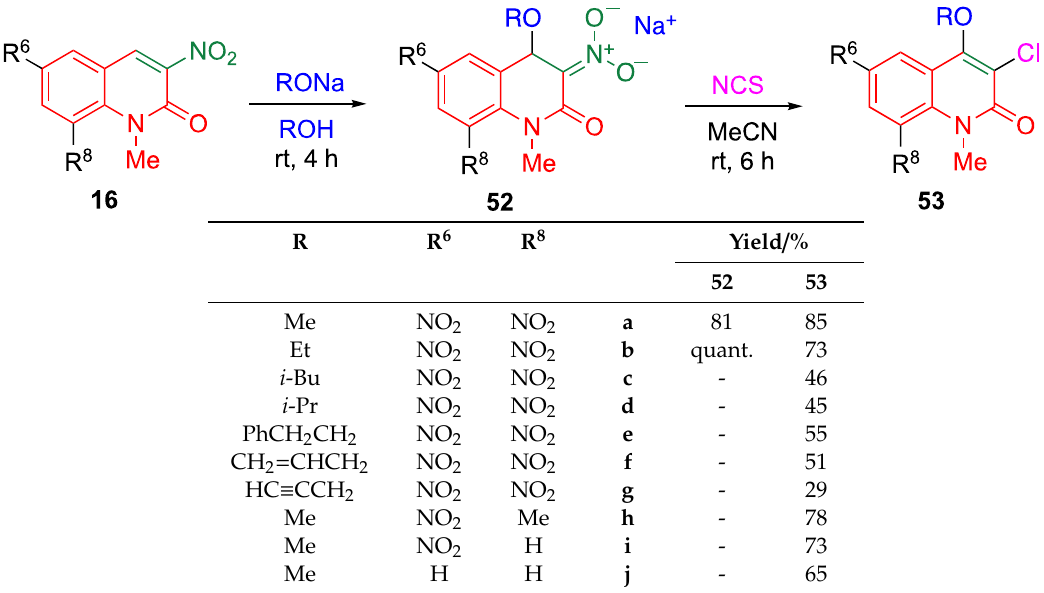
Table 17. Alkoxy-chlorination of 16 leading to 53 .